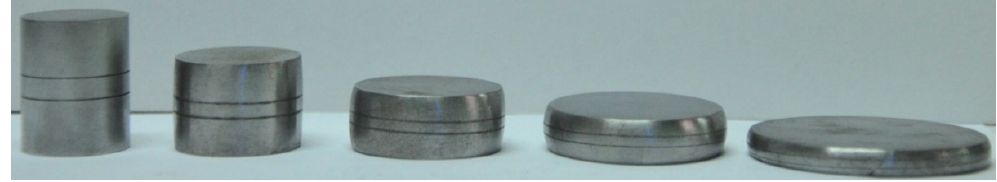
Figure 1. Deformed specimens after each forming pass. Table 1. Chemical composition of medium carbon steel C45E (Fe is balance).